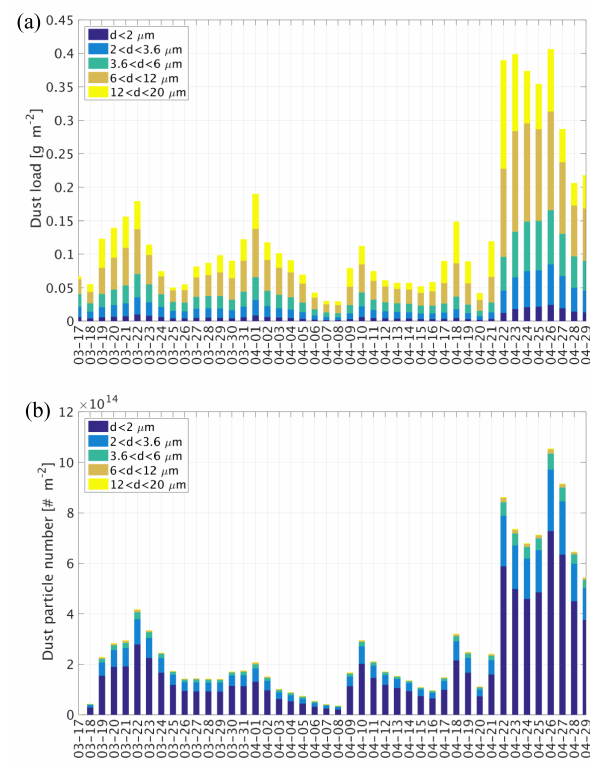
Figure 2. Time series of spatially averaged daily dust mass load (a) and daily number density of dust particles (b) over East Asia (do- main 1) during the simulation